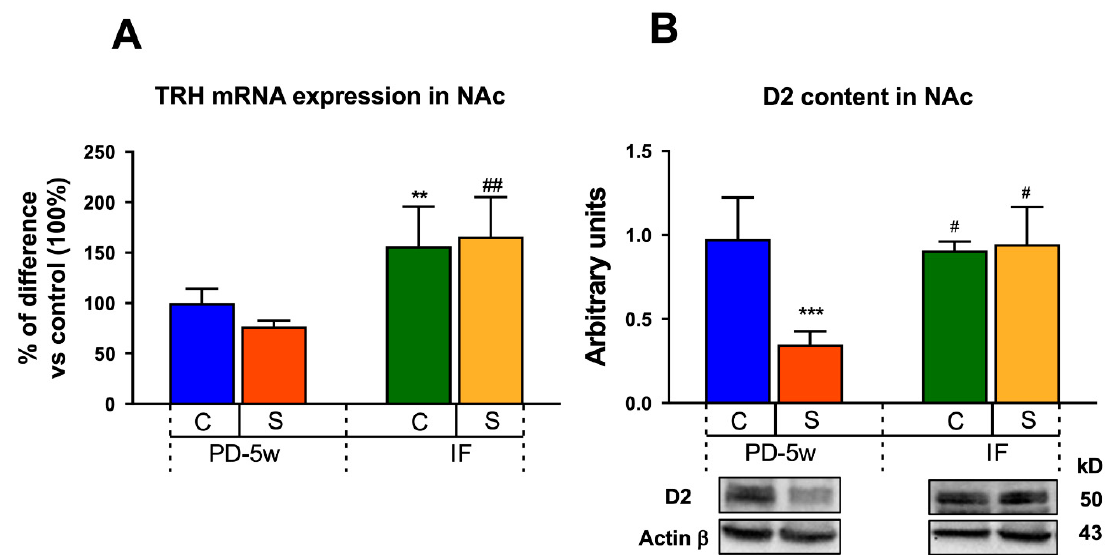
Figure 7. Effect of stress and intermittent fasting on limbic parameters. ( A ) TRH mRNA expression and ( B ) dopamine receptor type 2 (D2) content in the nucleus accumbens (NAc) of the control or stressed animals fed with a PD and subjected to two feeding schedules: food available all day (with a cumulative intake time of 5 weeks, C-PD-5w, S-PD-5w) or intermittent fasting (C-IF, S-IF) for 3 additional weeks. Data are expressed as the mean ± SEM expressed in % of difference vs. C-PD-5w, or in arbitrary units of the intensity of D2/actin signals (n = 4 rats/group). ** p < 0.01, *** p < 0.001 vs. C-PD-5w; # p < 0.05, ## p < 0.01 vs. S-PD-5w.